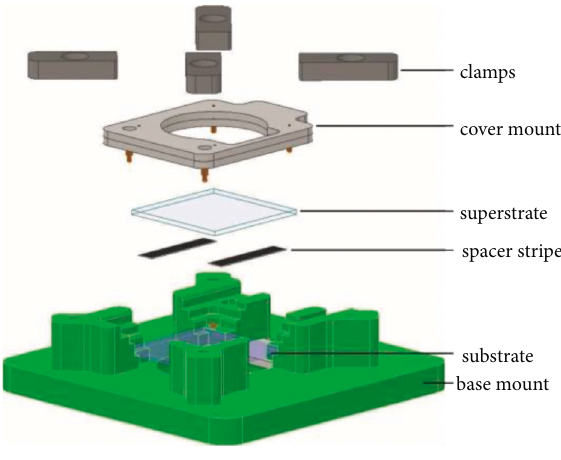
Figure 4: Exploded assembly drawing of set-up with lab-chip parts. The OEW light is entering the set-up from the bottom (possibly also from the top). The part, which is drawn green, is designed to be clipped into a commonly used microscope table. Substrate and superstrates (with their respective layers) are pressed into this mount separated by stripes of insulating the PVC tape. The whole assembly is joined mechanically by a cover mount (shown greyish here) and four